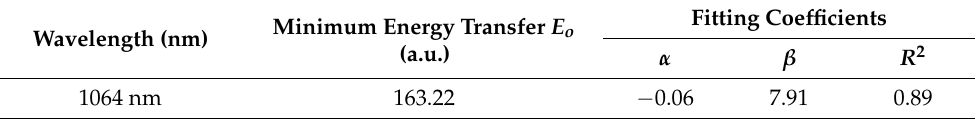
Table 2. Kinetic parameters of energy Figure 3. ( a ) The relationship between energy transfer and reflectance. ( b ) The change in resonance for different RI of the